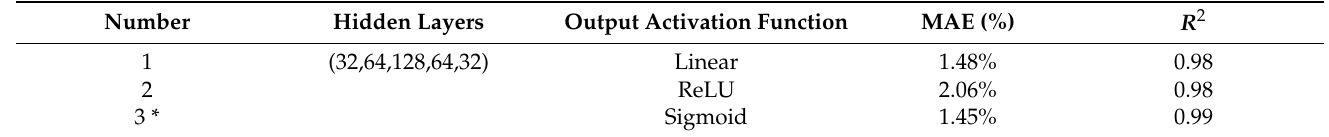
Table 3. Investigation of output layers activation